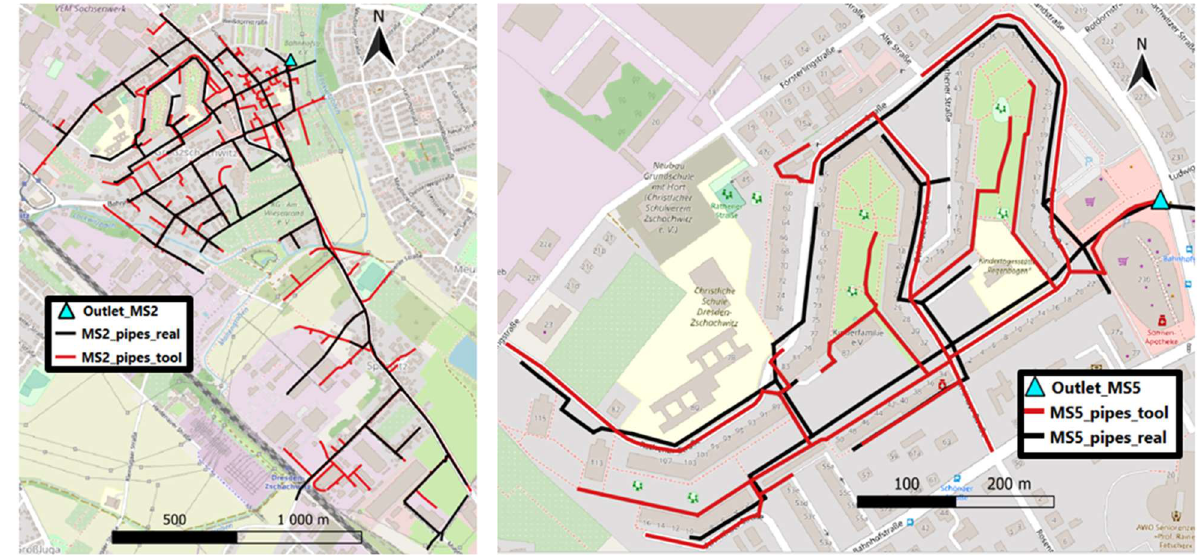
Figure 2. Comparison of generated and real sewer network layouts for MS2 ( left ) and MS5 ( right ).